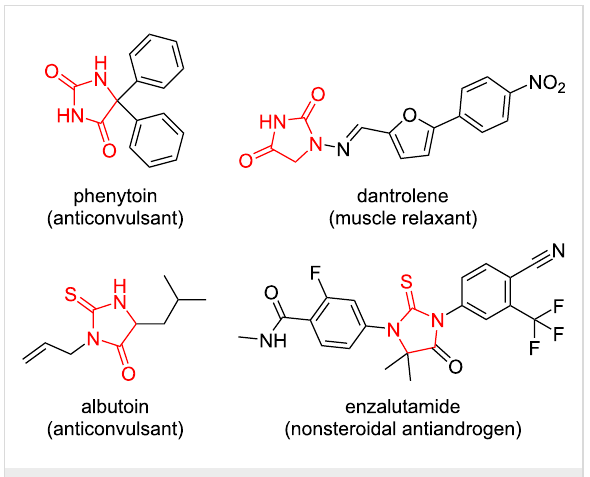
Figure 1: Hydantoin-based commercially available drugs.